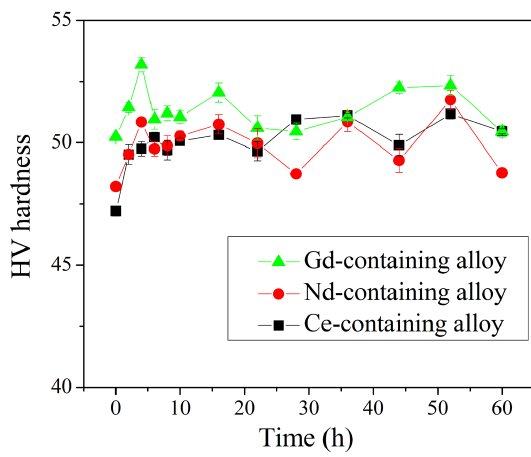
Figure 7. Curves of HV hardness-aging time of RE-containing alloys.